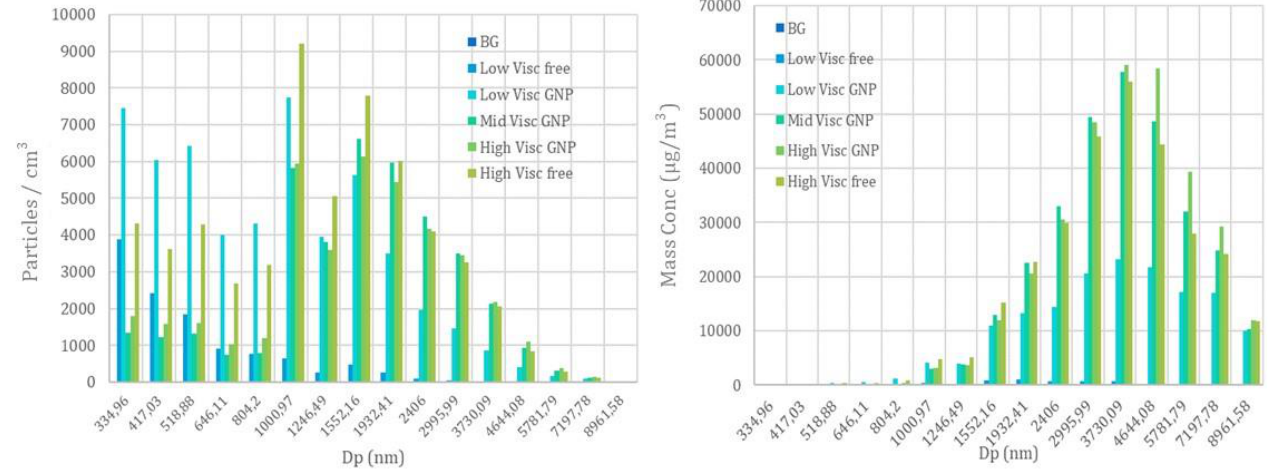
Figure 9. Plot of the particle number concentration ( left ) and mass concentration taken from the OPS device ( right ).